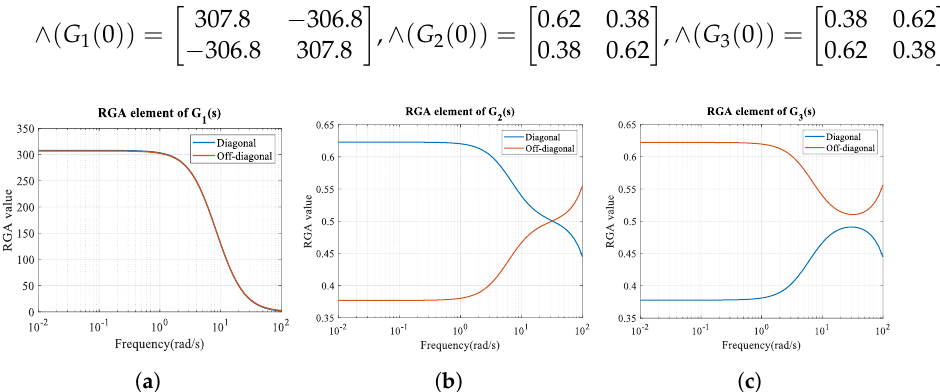
Figure 5. RGA elements of the plant. ( a ) RGA element of G 1 ; ( b ) RGA element of G 2 ; ( c ) RGA element of G 3